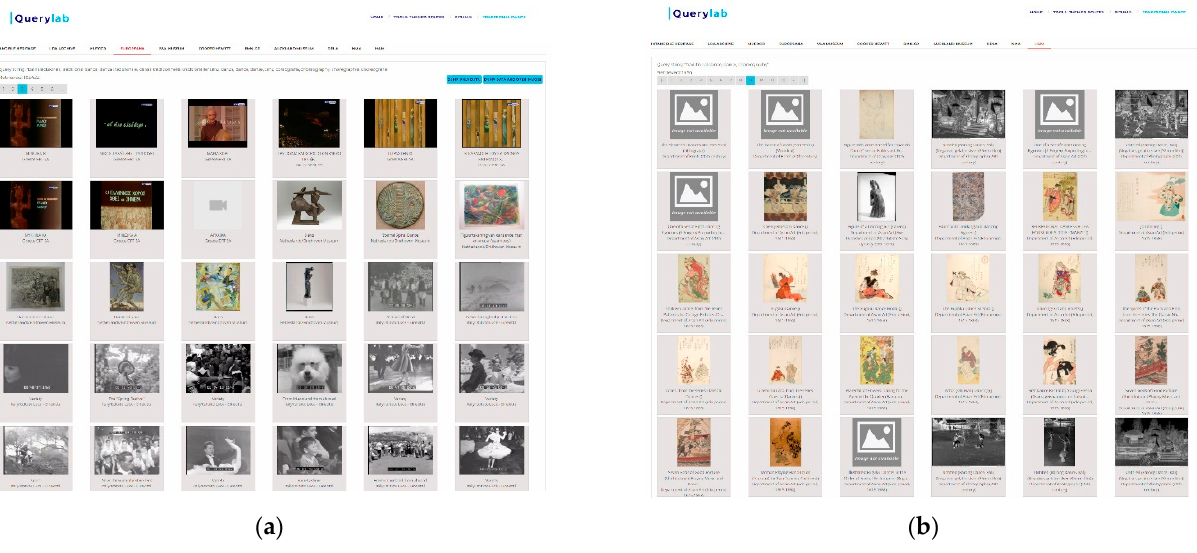
Figure 8. Results for query “Rituals/Traditional dances”: ( a ) from Europeana archives; ( b ) from Harvard Art Museum.